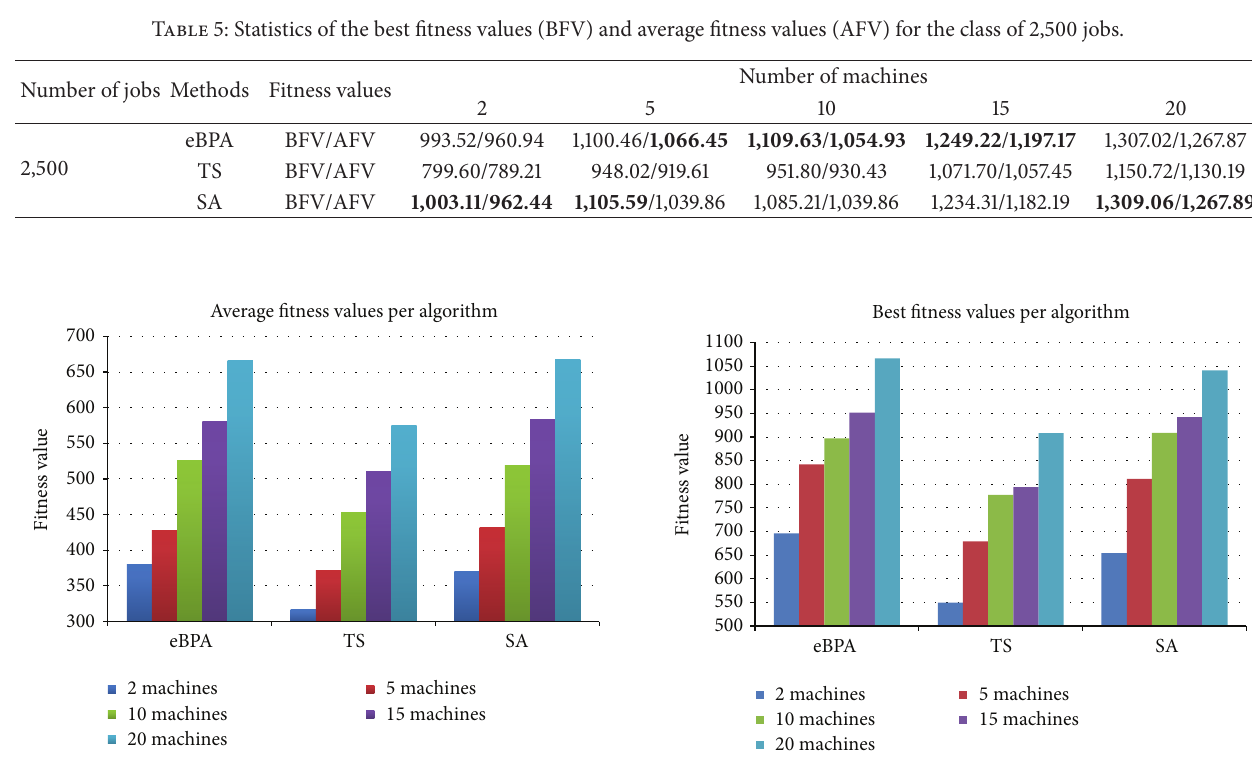
Figure 2: AFV comparisons for the class of 500 jobs.